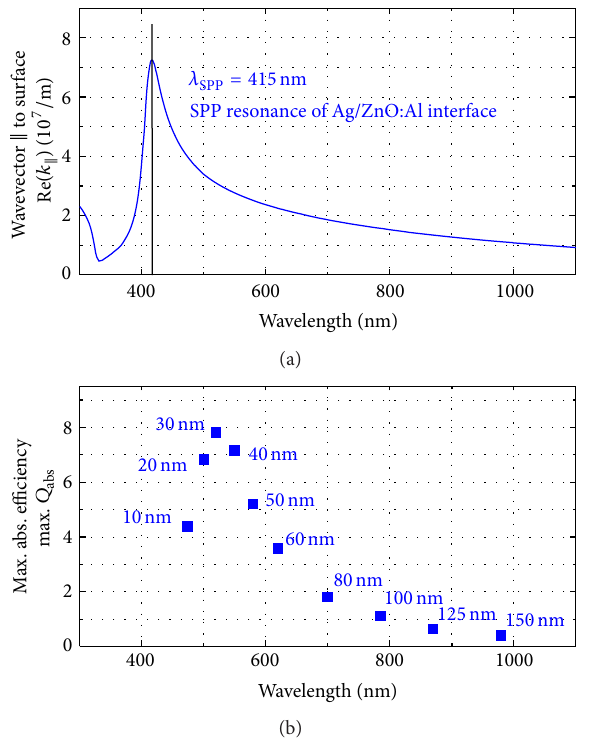
Figure 5: (a) Dispersion relation of SPP modes calculated according to (1). SPP modes propagating along a flat Ag surface covered with ZnO:Al half space as a function of the real part of the wave-vector parallel to the surface ( 𝑘 ‖ ). (b) Maxima in simulated absorption efficiency (max. 𝑄 abs ) of LSP resonances in hemispherical Ag nanostructures as a function of the resonance wavelength ( 𝜆 res ) covered by ZnO:Al. The radius of the hemispherical nanostructure is varied from 10 nm to